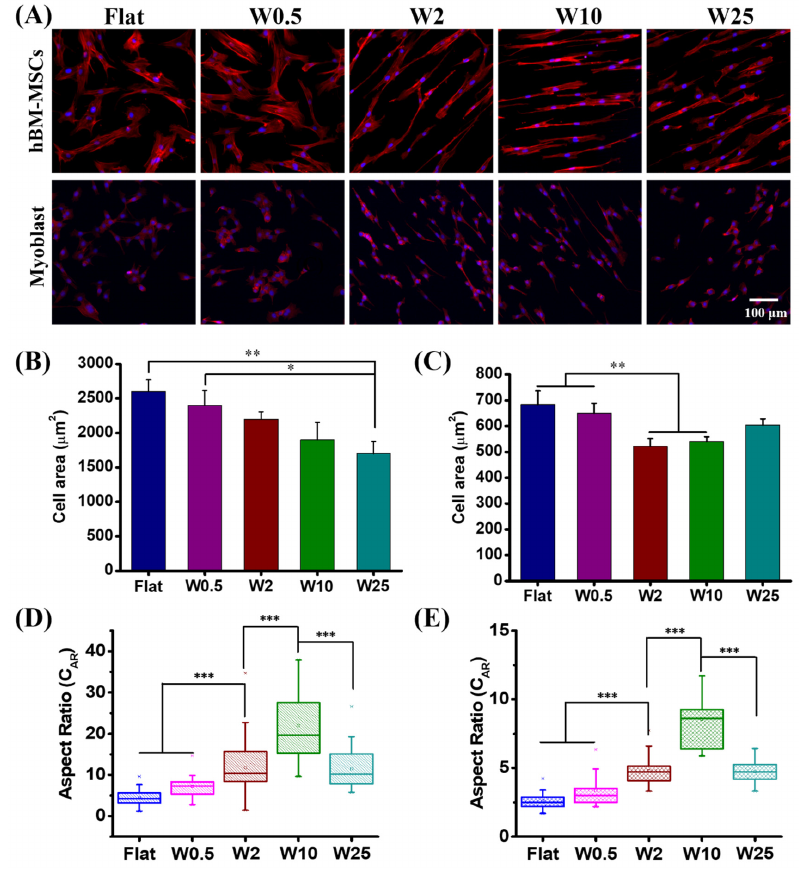
Figure 2. Influence of nano- and micropatterns on the morphology of hBM-MSCs and myoblast cells. ( A ) Representative fluorescence microscopy images of hBM-MSCs and myoblast cells grown on different wrinkle surfaces. F-actin and cell nucleus were stained with TRITC-labeled phalloidin (red) and by DAPI (blue), respectively. ( B ) Cell area of hBM-MSCs and ( C ) myoblast cells grown on different topographies. ( D ) Cell aspect ratio (C AR ) of hBM-MSCs and ( E ) Myoblast cells grown on different topographies. Data are shown as mean ± standard deviation (SD), and * p < 0.05, ** p < 0.01, *** p < 0.001. Scale bar is 100 µm for all images.